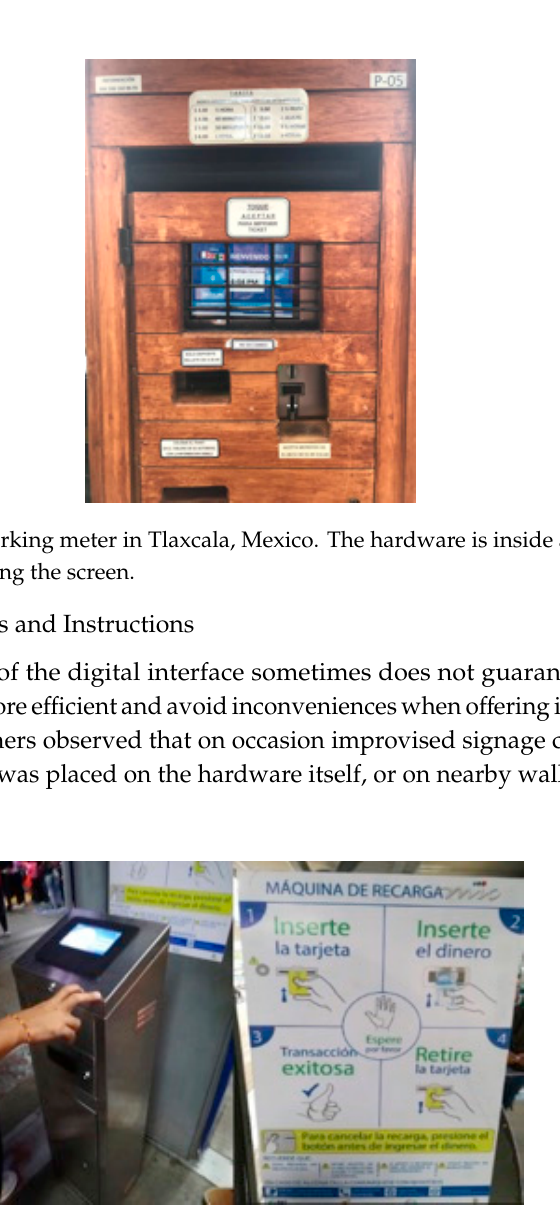
Figure 25. Left image ( a ) Mio, a public bus transportation machine in Cali. Bad placed, weather conditions can affect machine performance. Right image ( b ) a CFE-Matic ATM in Mexico City used for paying electricity bills. Too much direct sunlight makes using the interface very complicated.